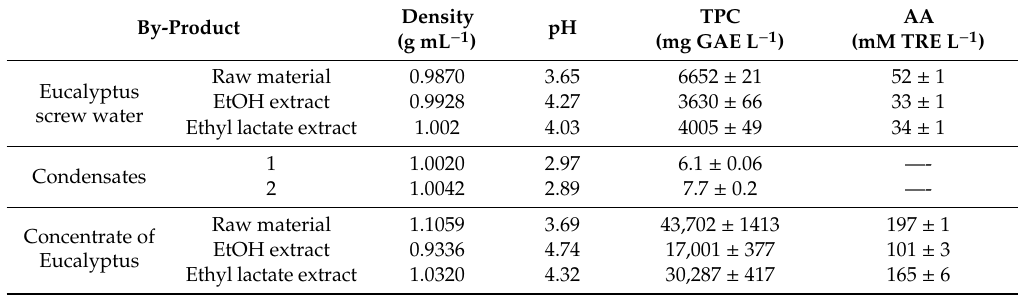
Table 1. Density, pH, TPC and AA values for the studied by-products and their derived extracts.